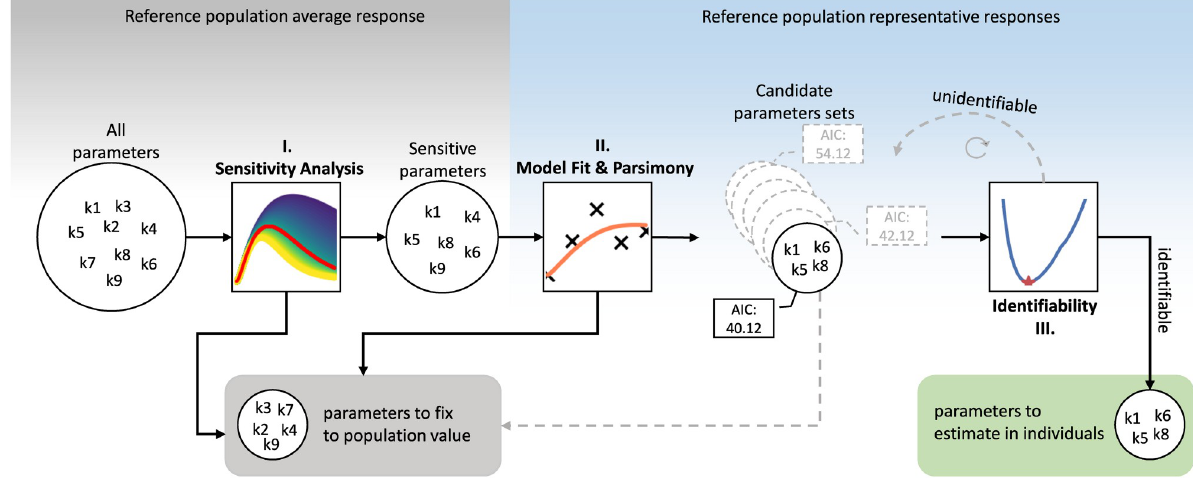
Fig 1. Flowchart of the model selection